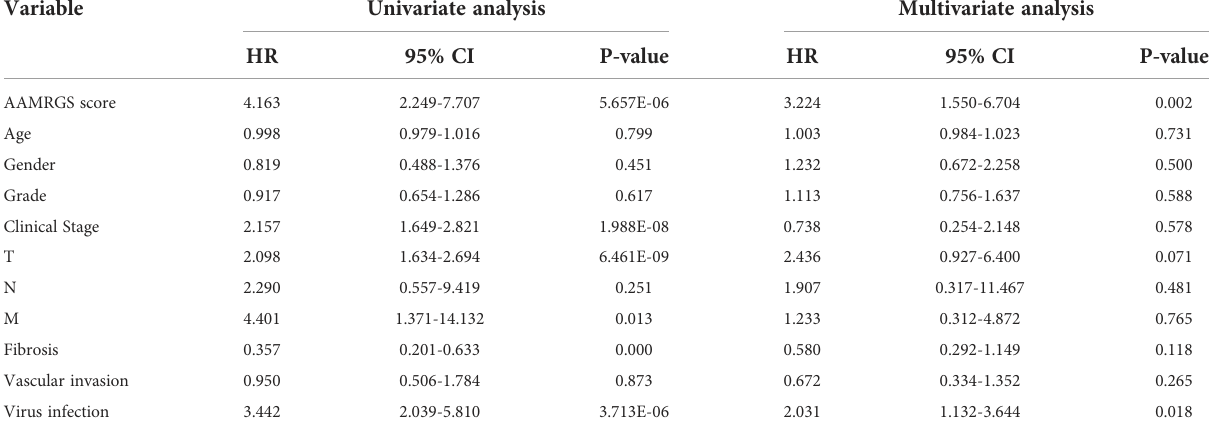
TABLE 3 Univariate and multivariate Cox regression analyses of the AAMRGS score in the TCGA.